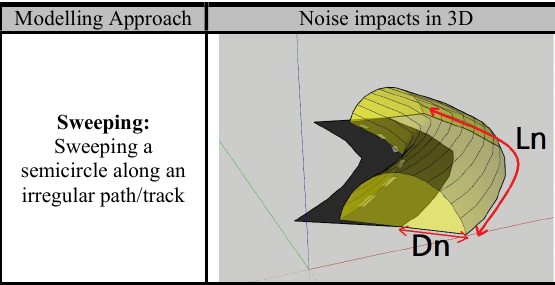
Table 5 . Modelling noise impacts LuR based on its identified parameters